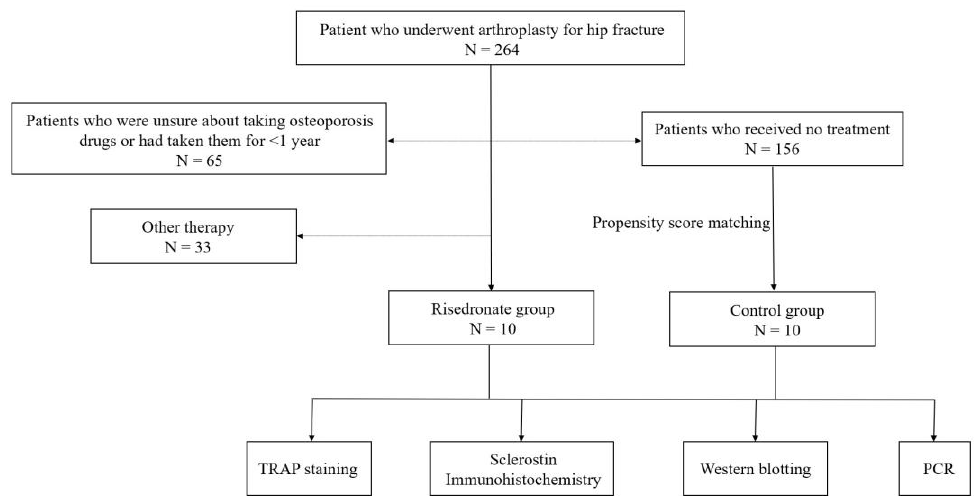
Figure 1. Flow chart of the study.